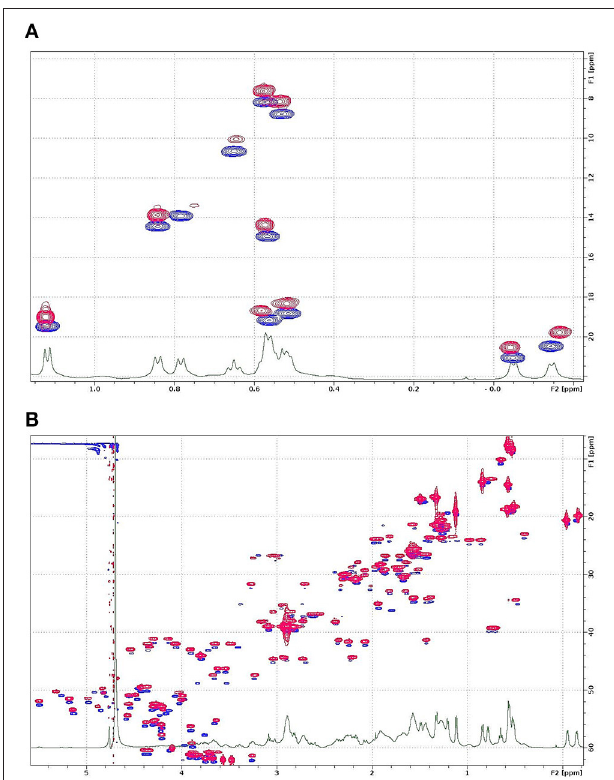
FIGURE 6 | 13 C- 1 H HSQC spectra of rNFAP2 and sNFAP2: (A) Methyl and (B) aliphatic CH region of rNFAP2 (red) and sNFAP2 (blue). Overlaid spectra are intentionally shifted in the vertical 13 C axis direction for better visibility. rNFAP2: recombinant NFAP2 produced by P. chrysogenum nfap2 , sNFAP2: synthetic